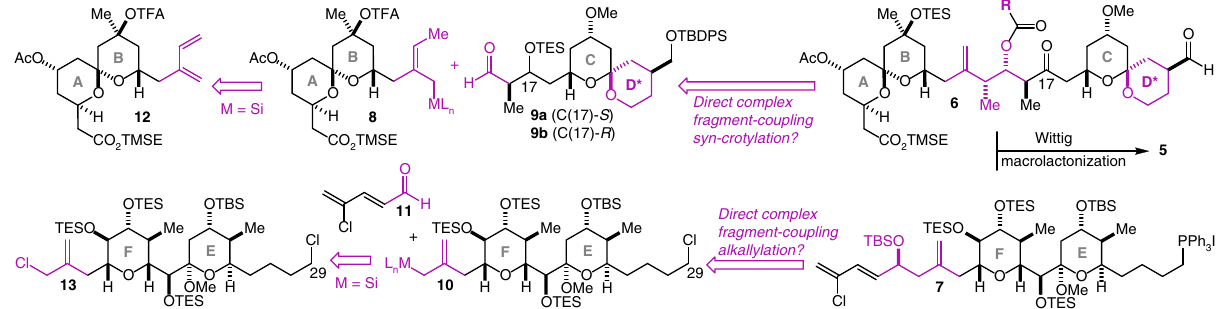
Fig. 2 Retrosynthetic analysis. The target molecules may be split into the ABCD* ( 6 ) and EF ( 7 ) fragments, which may be coupled with a Wittig reaction, followed by macrolactonization to complete the synthesis. A direct complex fragment coupling syn -crotylation reaction of 8 with CD* spiroketal aldehyde 9a or 9b was envisioned as the key step in the synthesis of the ABCD* fragment, while a direct complex fragment coupling alkallylation reaction of 10 with aldehyde 11 was envisioned as a critical step in the synthesis of the EF fragment. Crotyl- and allylsilanes 8 and 10 (M = Si) were envisioned to arise from diene 12 and allylchloride 13 , greatly simplifying the synthesis. TFA tri fl uoroacetate, TMSE 2-trimethylsilylethyl, TES triethylsilyl, TBDPS tert - butyldiphenylsilyl, TBS tert